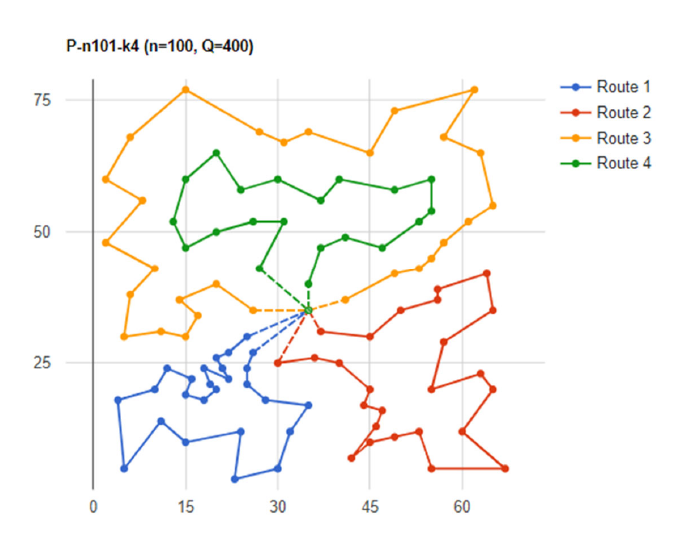
Fig. 1. An example